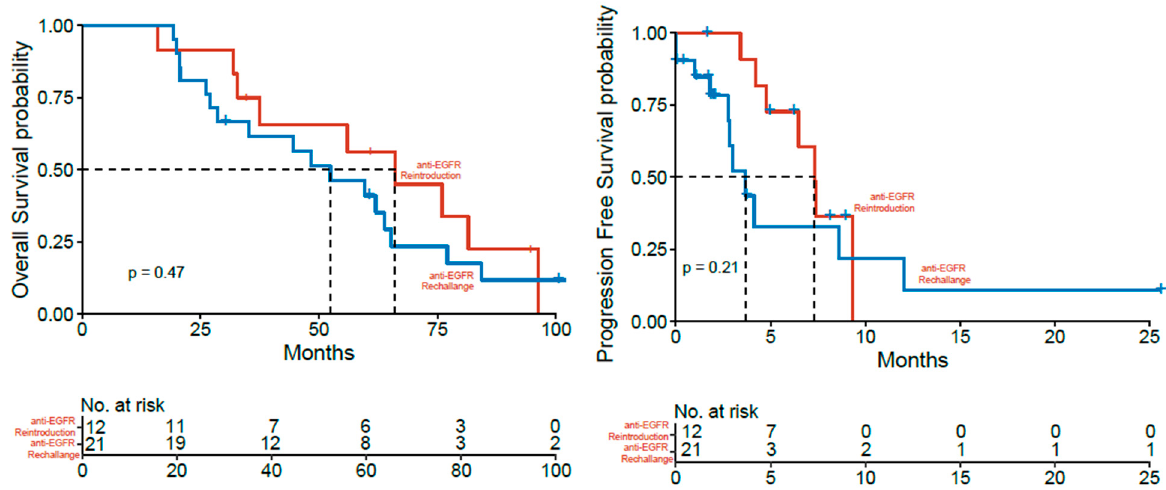
Figure 4. Kaplan-Meier estimator for overall ( left ) and progression-free ( right ) survival in patients with anti-EGFR reintroduction ( red ) and rechallenge ( blue ). Table 2. Characteristics of patients receiving anti-EGFR treatment.